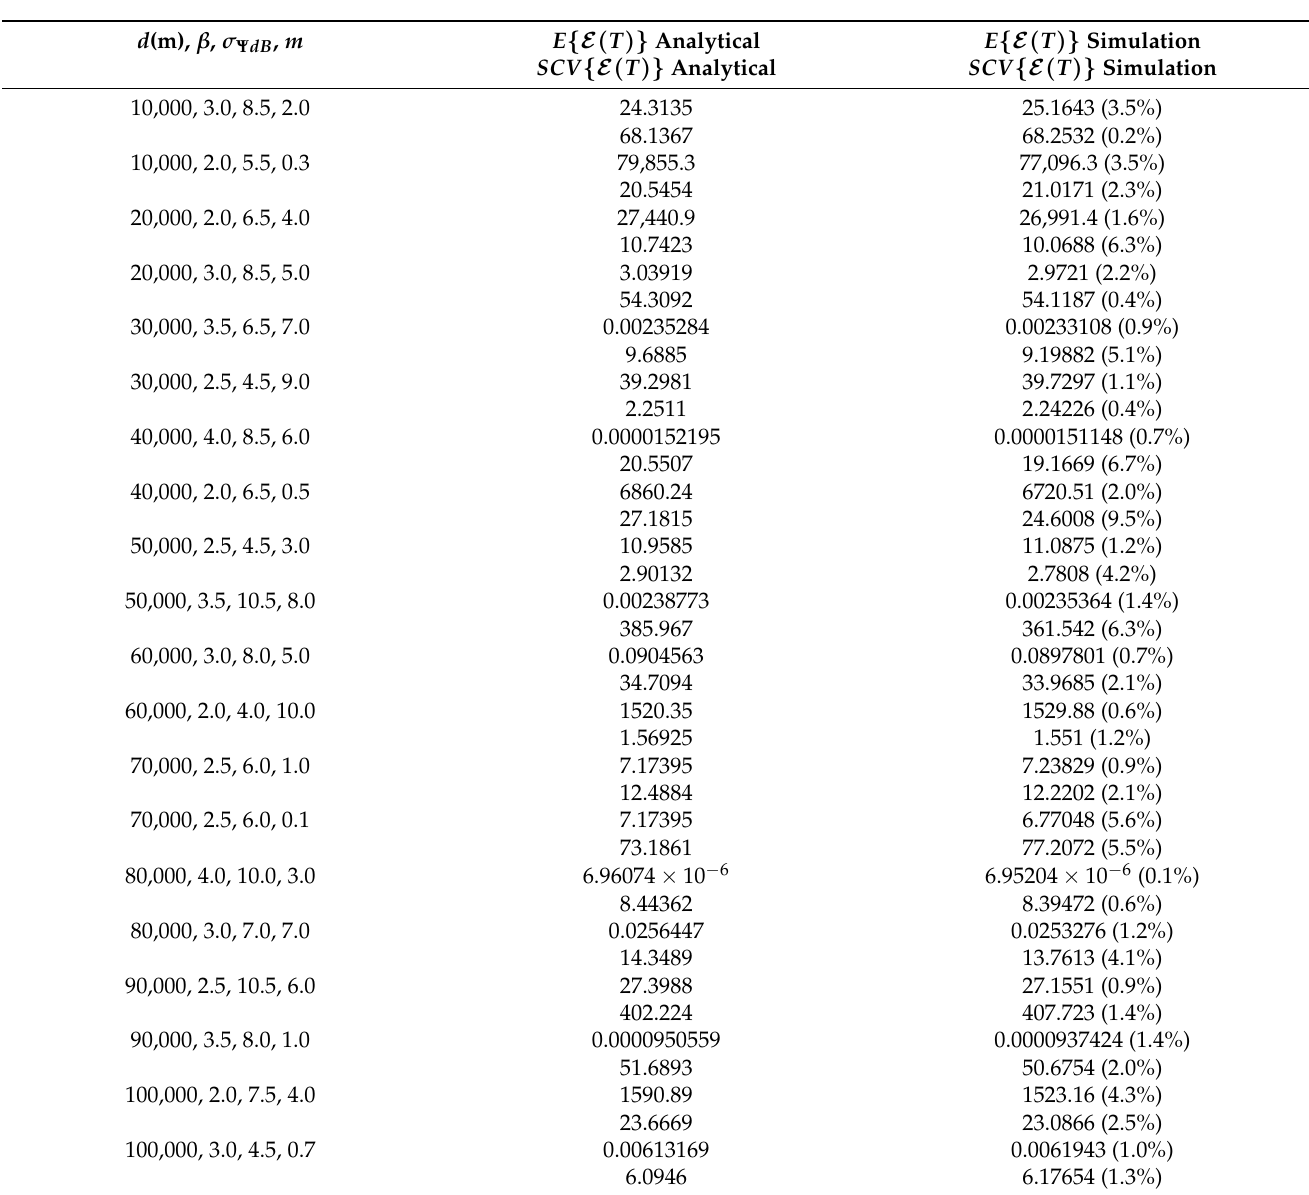
Table 2. Comparison between analytical and simulation results for different parameter sets. The relative error (in absolute value) incurred by the simulation results has also been